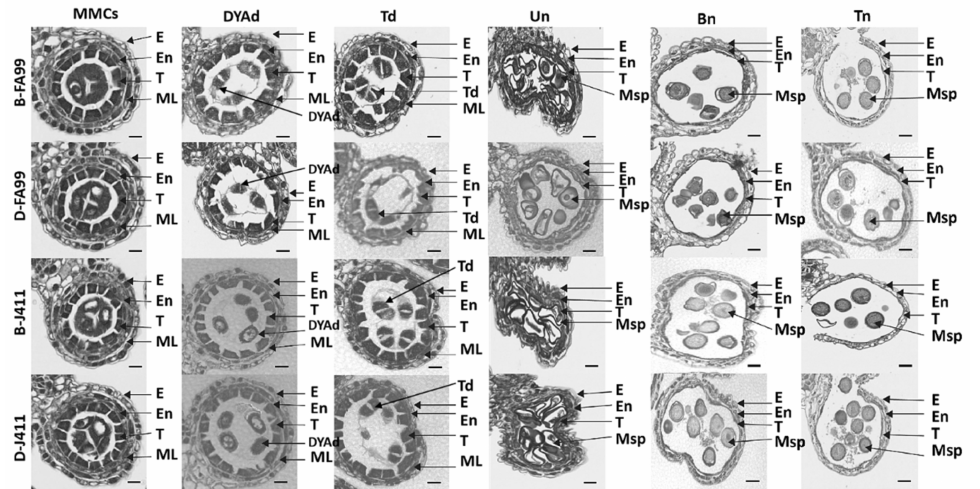
Figure 2. Comparative analysis of paraffin sections of FA99 and J411 anthers at different stages in different fertility environments. MMCs: microspore mother cell stage; DYAd: dyad stage; Td: tetrad stage; Un: uninucleate stage; Bn: binucleate stage; Tn: trinucleate stage; E: Epidermis; En: Endothecium; ML: Middle layer; T: Tapetum; Msp: Microspores; Scale bars = 50 µ